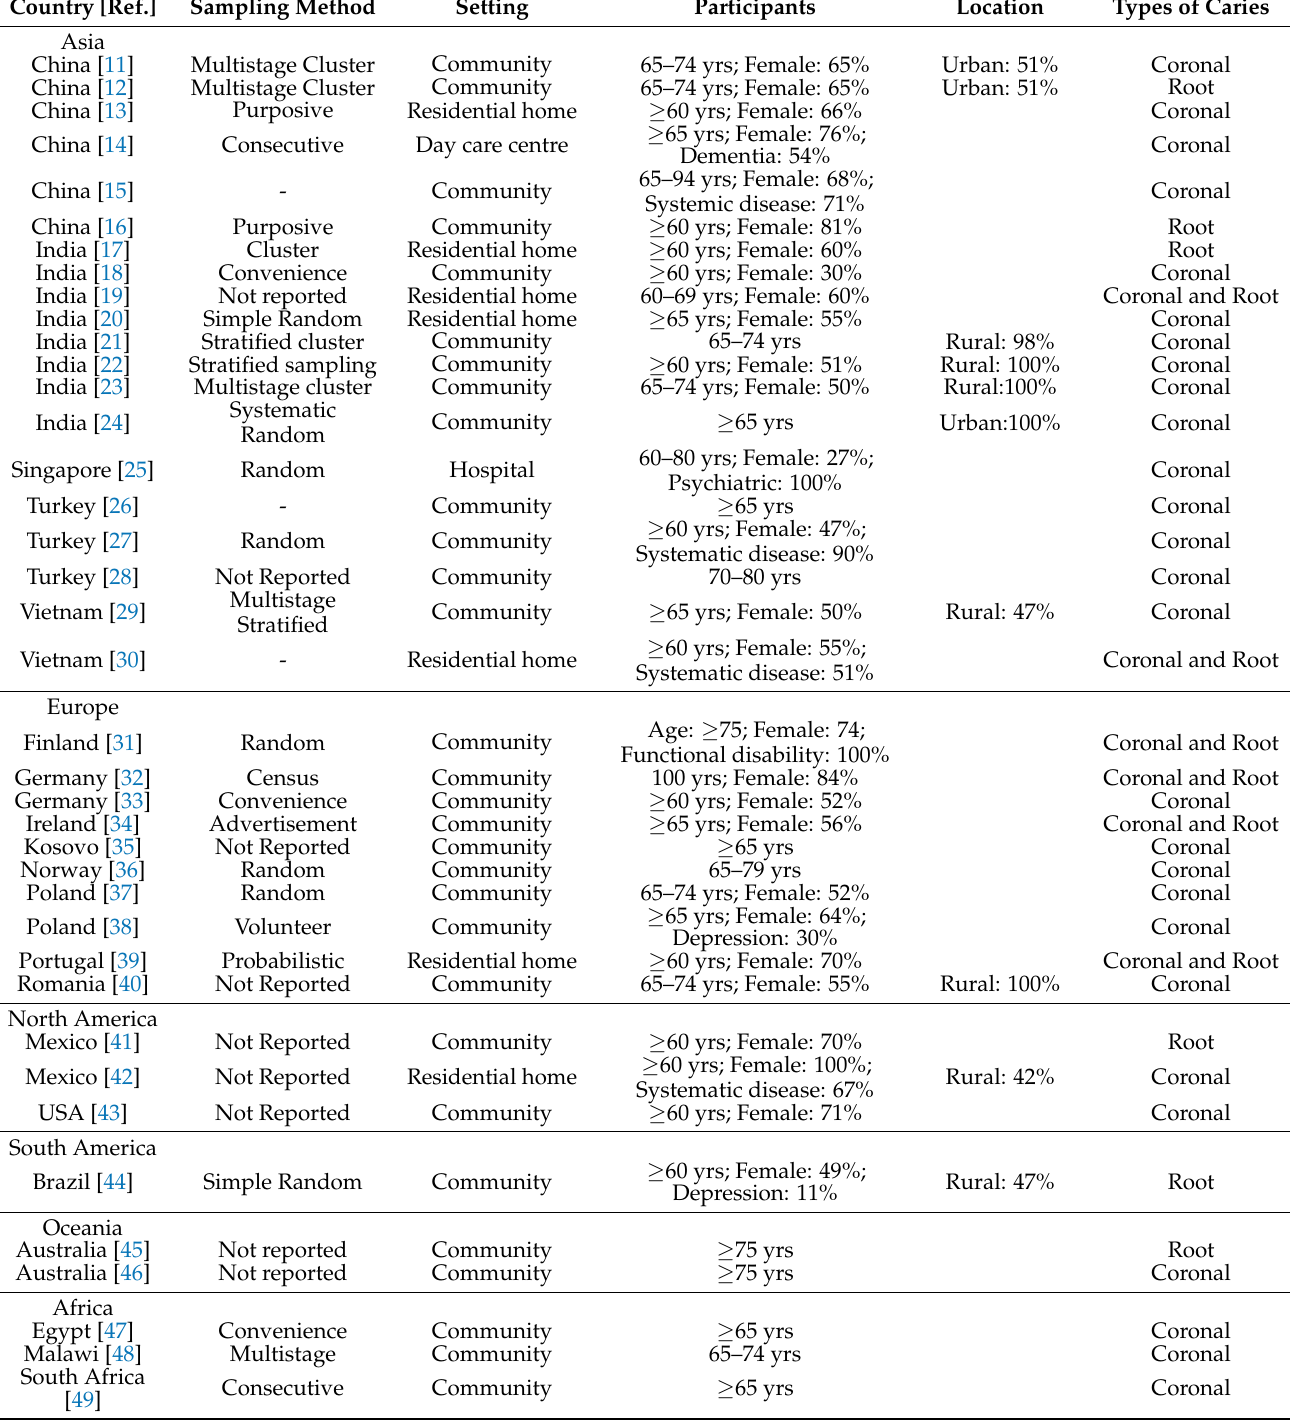
Table 2. Summary of the included studies: Study origin, sampling, demographics and types of caries reported. Country